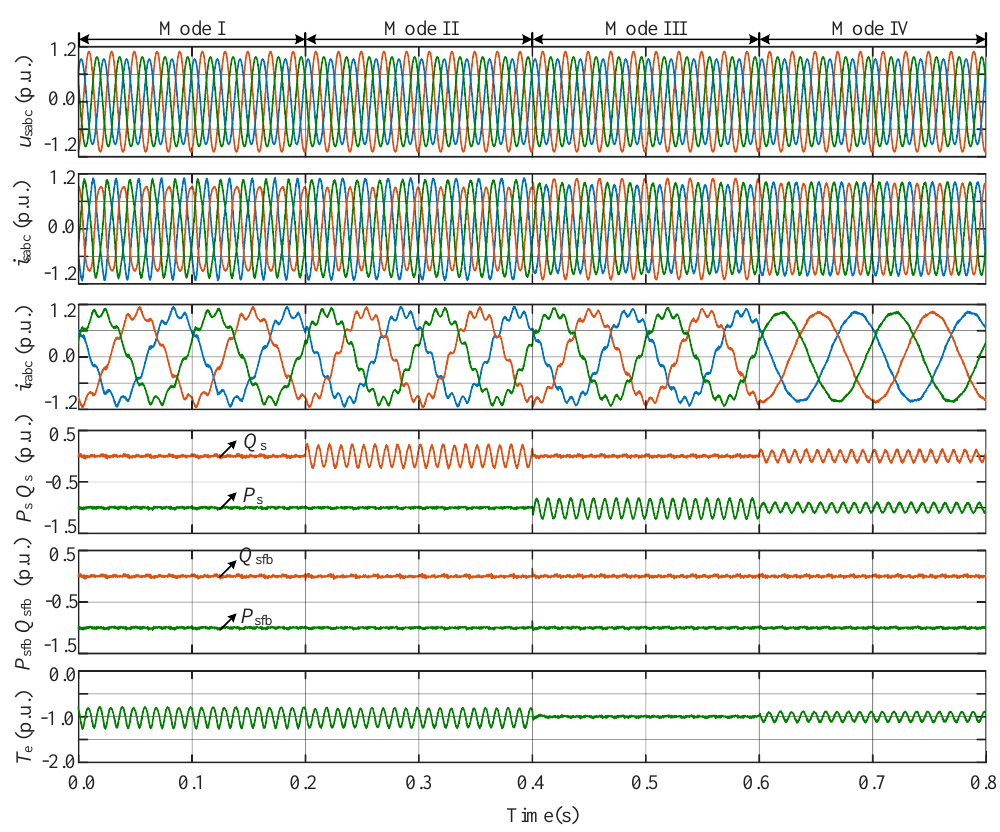
Figure 6. Simulation results during a 10% steady-state voltage unbalanc.